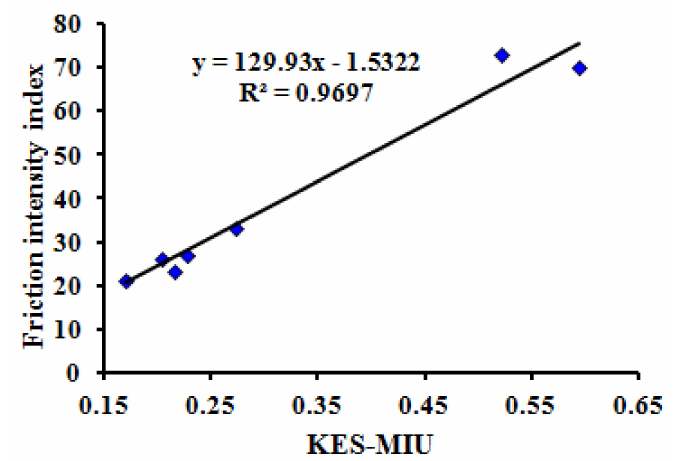
Figure 8. Relationship between intensity index of friction ( FII ) of MTT test and KES friction coefficient